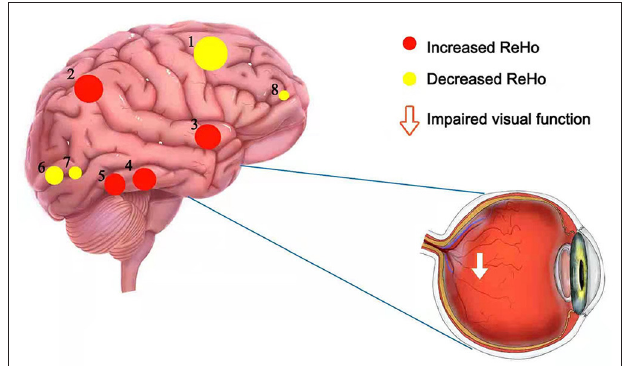
FIGURE 5 | The schematic brain region map of CB patients with significant ReHo differences compared to HC. The ReHo values of CB patients were reduced to varying degrees compared with HCs in the following regions: 8-the right orbital part of the middle frontal gyrus (BA 32, t = − 5.62), 6-the right middle occipital gyrus (BA 18, t = − 5.96), 7-the left middle occipital gyrus (BA 18, t = − 5.94), 1-the right dorsolateral superior frontal gyrus (BA 8, t = − 8.75). Instead, the ReHo values of CB patients in the following regions were increased compared with HCs: 5-the right thalamus ( t = 5.98), 4-the left thalamus ( t = 6.23), 3-the right insula ( t = 6.2), 2-the left paracentral lobule (BA 3, t = 8.21). CB, congenital blindness; HC, healthy control; ReHo, regional homogeneity; BA, Brodmann’s